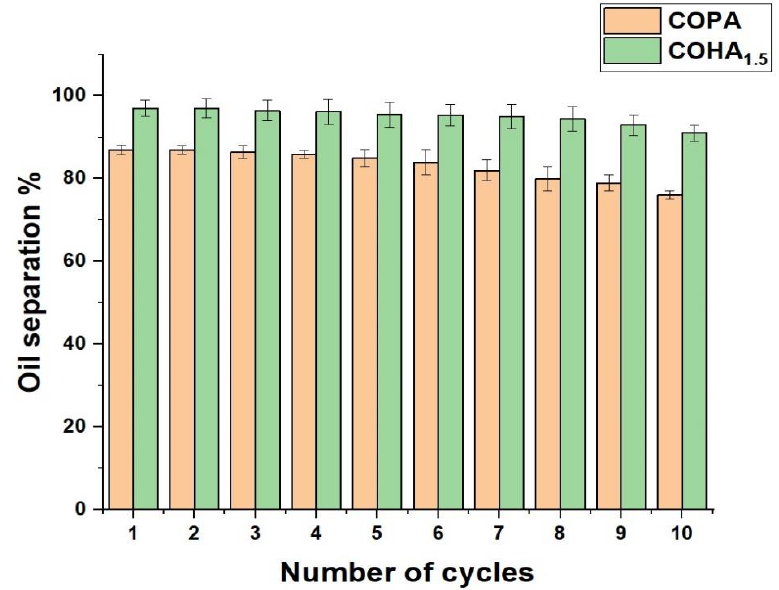
Figure 9. Reusability of the membrane for oil/water emulsion separation.